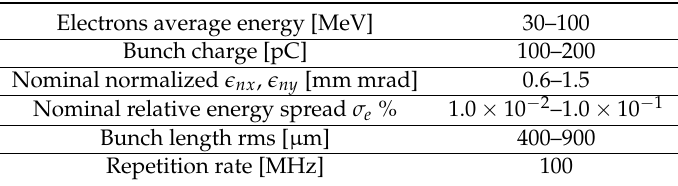
Table 2. Electron beam parameters at the Linac